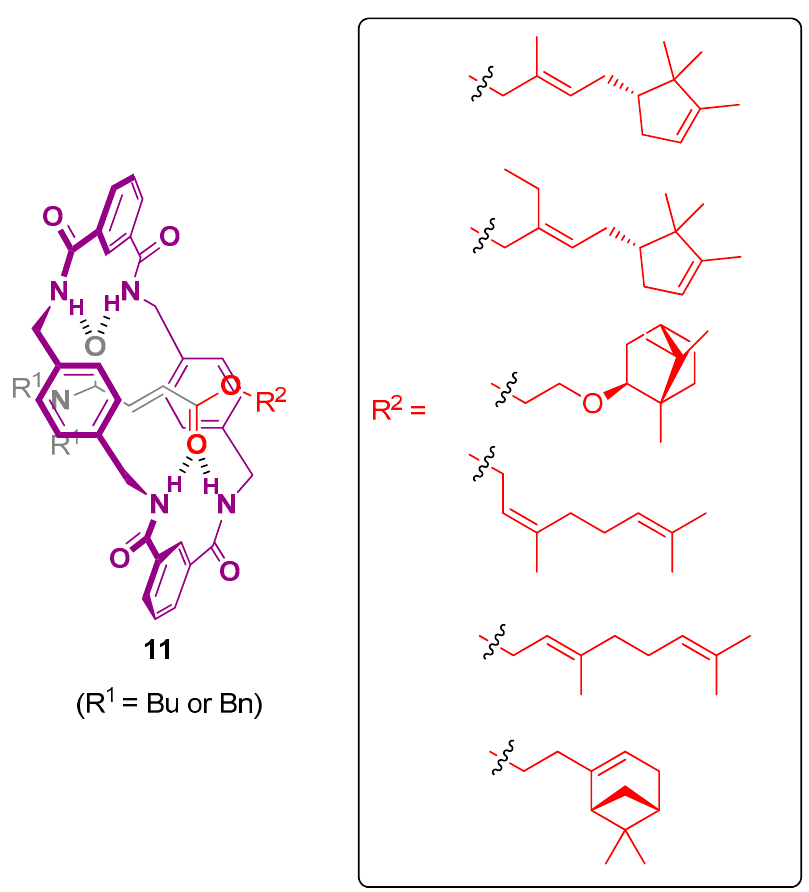
Figure 14. Chemical structure of the interlocked fumaramate-based profragrances 11 , highlighting the scent-based stopper. The fragments of the scents are included in a box. The original results were reported by Pastor, Berna and coworkers [137]. The ester hydrolysis reaction which provides the target alcohol-based scents has not been included in the figure.